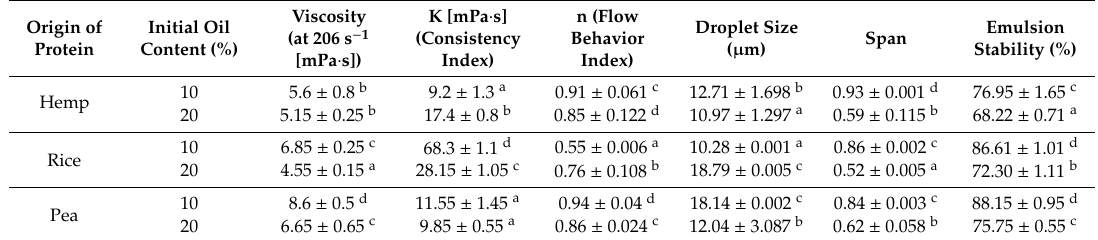
Table 1. Rheological properties, droplet size, and stability of emulsions prepared with hempseed oil and combination of proteins with maltodextrin.